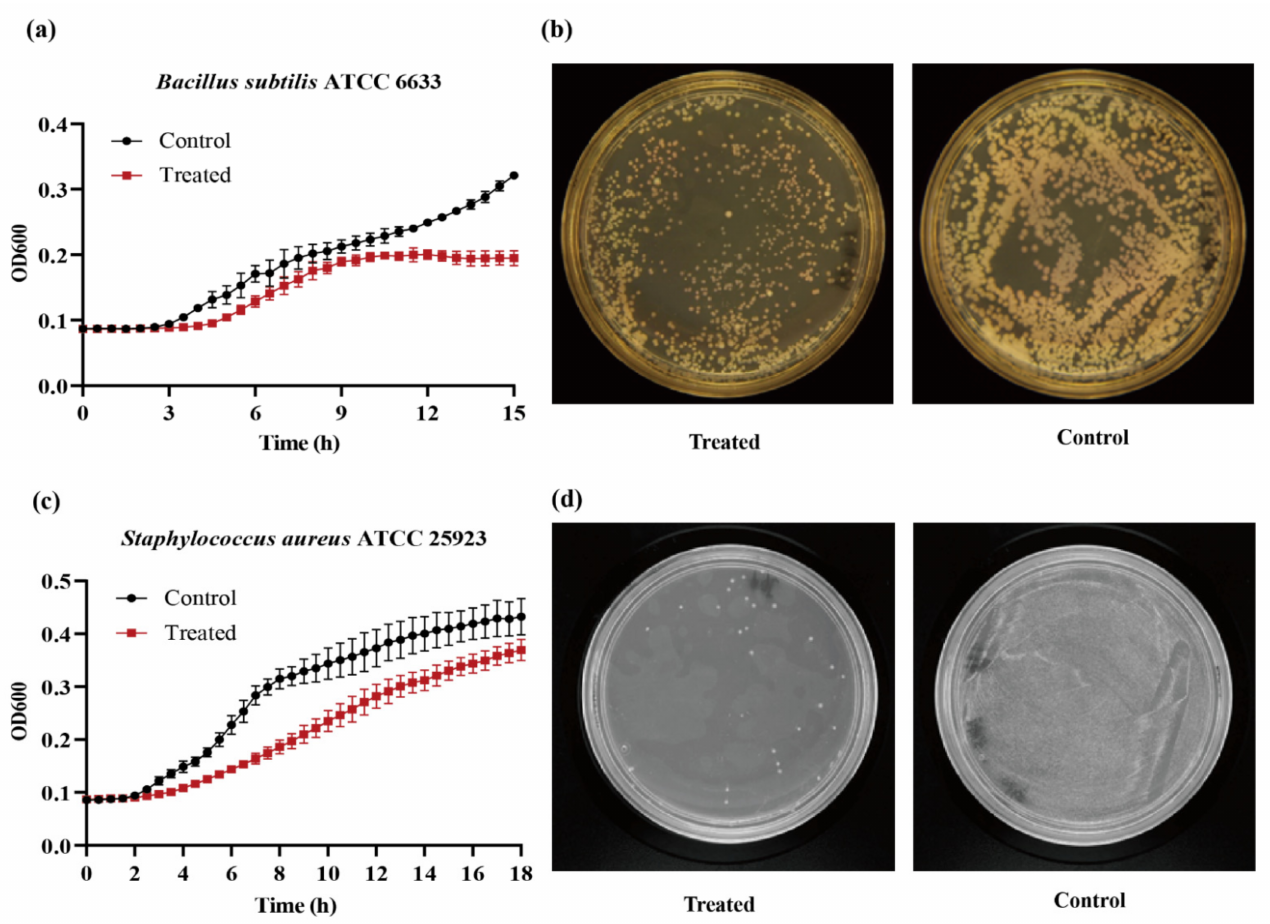
Figure 3. Bioactivity of the 020402_LYZ M1 protein. ( a ) The growth curves of B. subtilis ATCC 6633. ( b ) The dilution coating plate experiment of B. subtilis ATCC 6633. ( c ) The growth curves of S. aureus ATCC 25923. ( d ) The dilution coating plate experiment of S. aureus ATCC